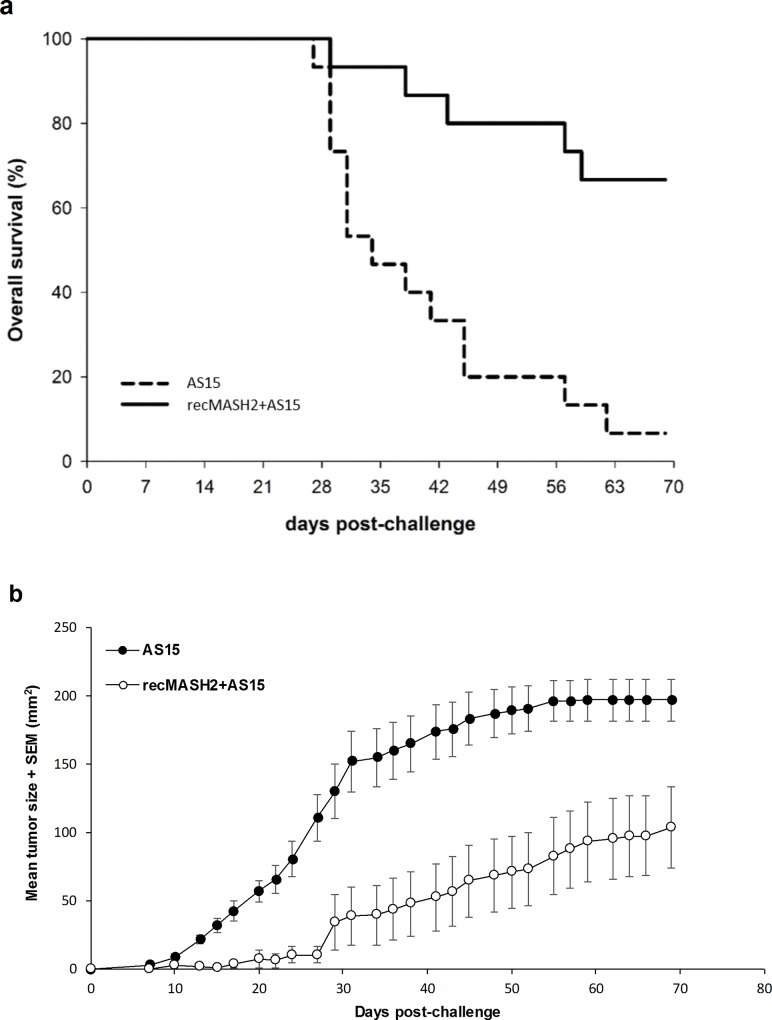
Response of CB6F1 mice to a challenge with TC1-MASH2 tumor cells.a) Kaplan-Meier survival analysis. b) Change in tumor growth over time as determined by caliper measurements (p≤0.009). recMASH2+AS15, recombinant mouse achaete scute homolog 2 protein combined with AS15 immunostimulant; SEM, standard error of the mean.